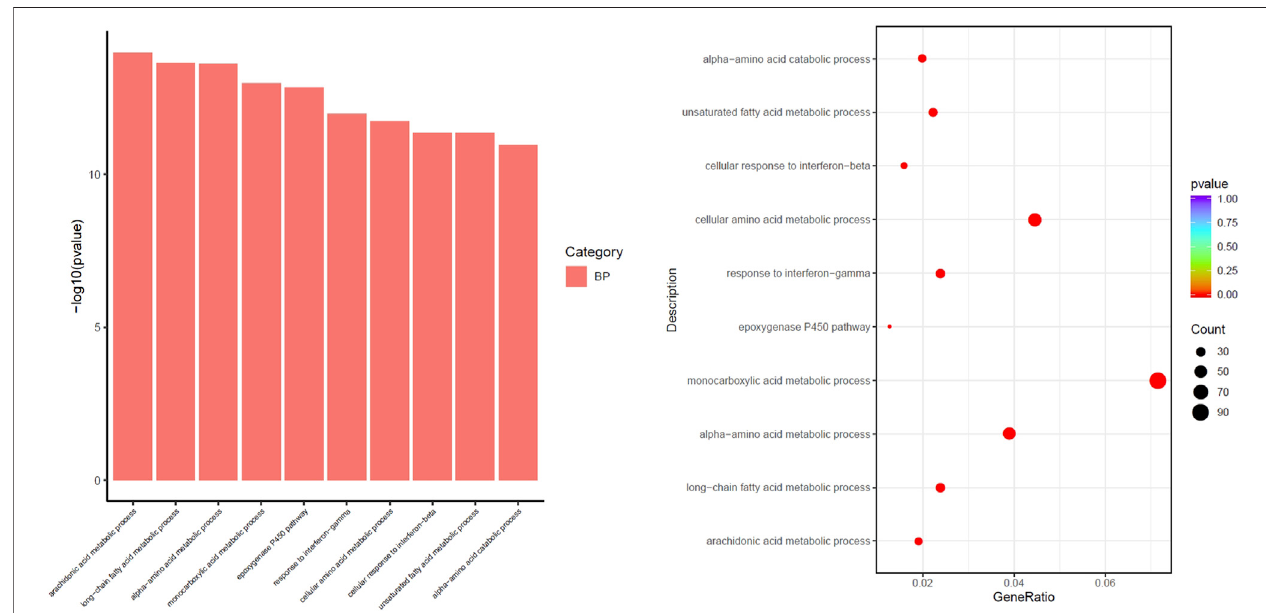
FIGURE 4 | Different biological process of upregulation in the group with PDR syndrome compared with the group with SKYD syndrome.